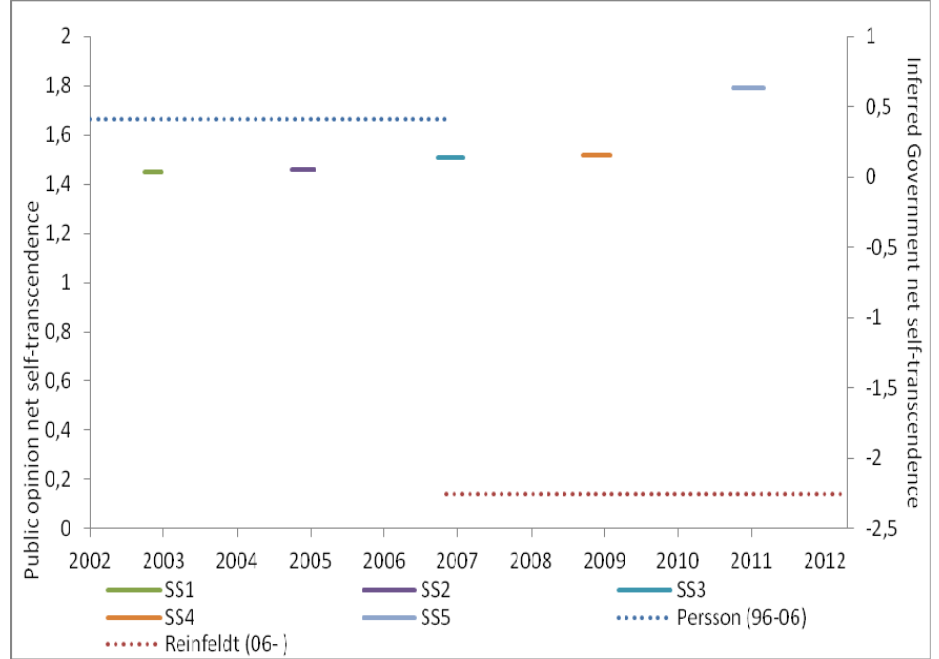
Figure 10: Net self-transcendence for Sweden